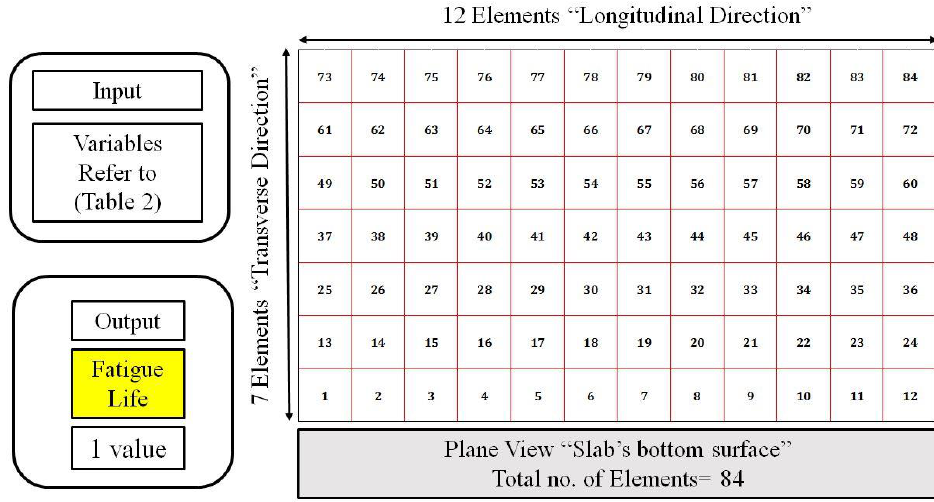
Figure 12. Input and output variables in fatigue life oriented neural network for cases (3) & (4).